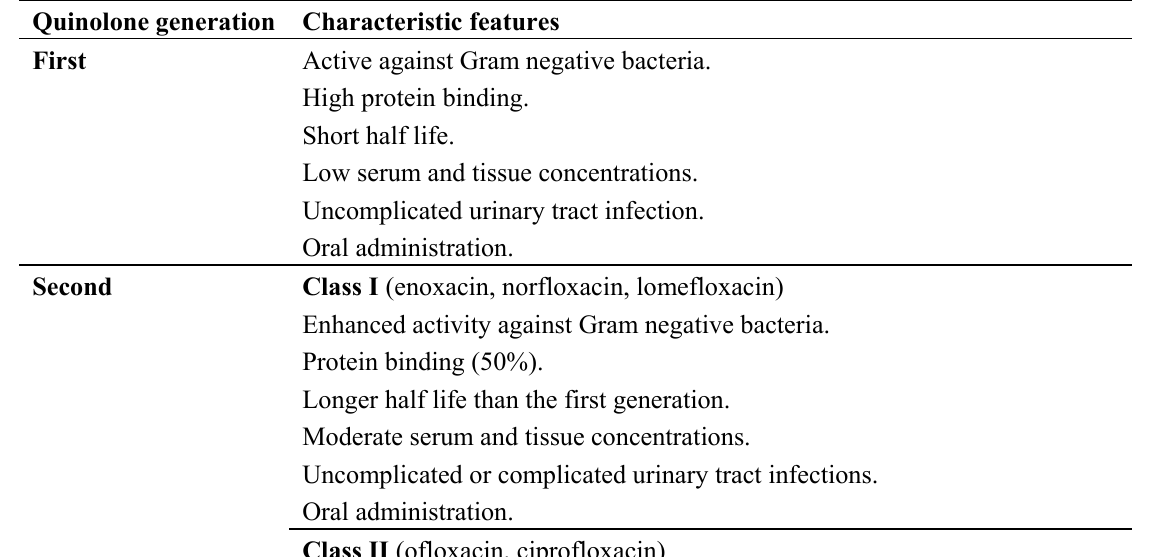
Table 2. Generations of quinolones based on their antibacterial spectrum and pharmacokinetic